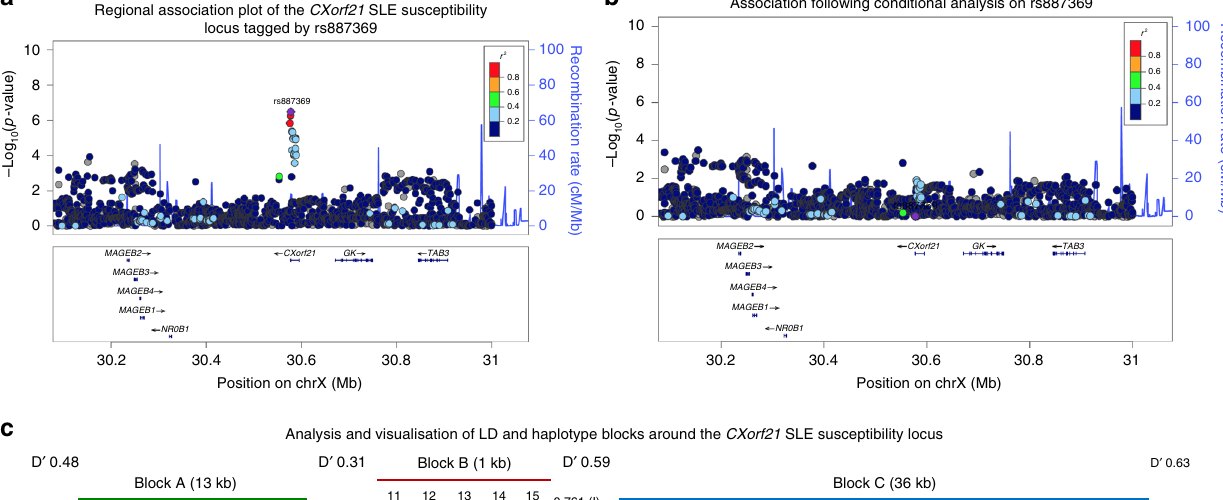
HaplotypeBlock Freq. Case, control frequencies X 2